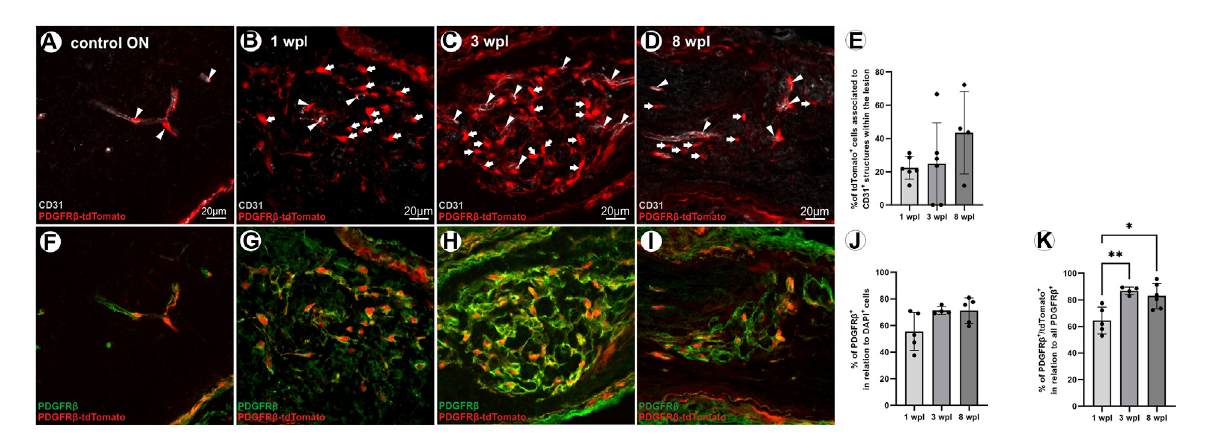
FIGURE 4 Vascular association of tdTomato + cells and PDGFR β IR of tdTomato + cells within the lesion over time. (A) In the control ON, the majority of tdTomato + cells are associated with CD31 + ECs, indicating vascular structures. (B) At 1 wpl, tdTomato + cells are homogenously distributed within the lesion, showing low association with CD31 + vascular structures. (C) At 3 wpl and (D) 8 wpl, again, minor vascular association of tdTomato + cells was detected within the lesion. (E) The % of association of tdTomato + cells with CD31 + vascular structures in the lesion, at the three time points investigated ( n = 4 – 6). (F) In the control ON, PDGFR β is speci fi cally expressed in vascular cells. Within the lesion, however, (G – I) PDGFR β + cells form a network-likestructure,mainlylackingassociationwithvascularstructures. (J) ThepopulationofPDGFR β + cellswithinthelesion1wpl( n =5),3wpl( n =4), and 8 wpl ( n = 5). (K) The percentage of these PDGFR β + cells that are also positive for tdTomato ispresented for 1 wpl ( n = 5),3 wpl ( n = 4), and 8 wpl ( n = 6). Signi fi cance was calculated by one-way ANOVA and Tukey ’ s multiple comparisons test; * p < 0.05 and ** p < 0.01. All pictures are representative